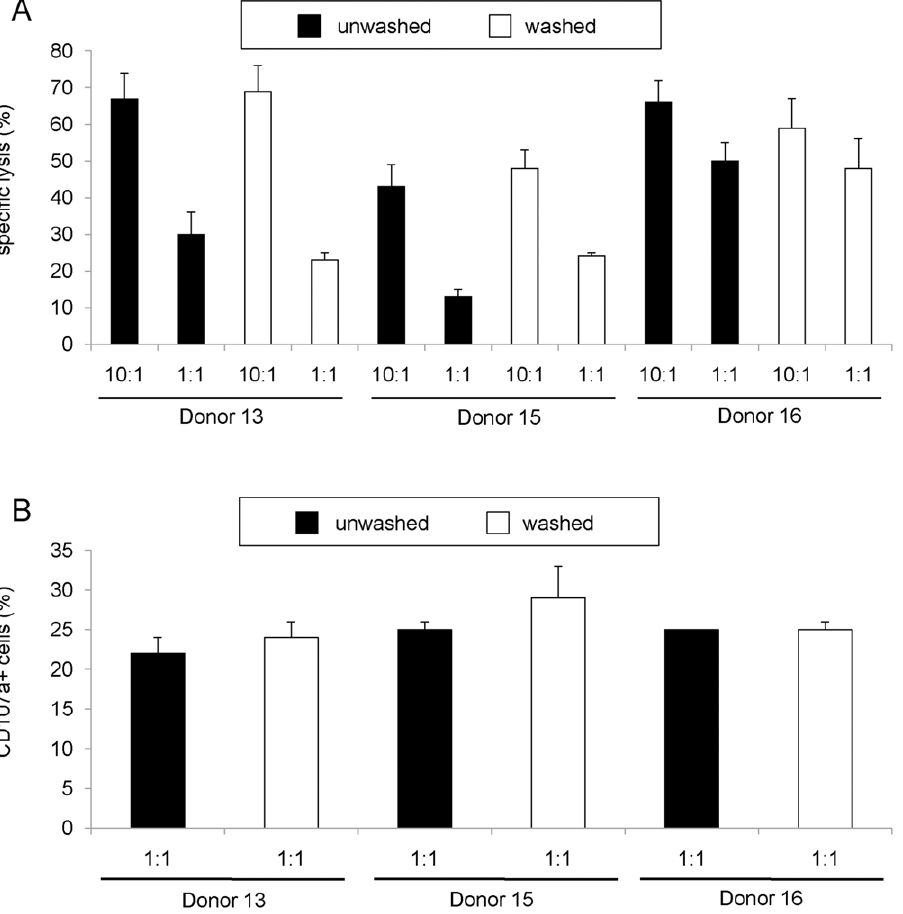
Figure 2. Functional activity of e xvivo bioreactor-expanded NK cells before and after the washing process. ( A ) Cytotoxicity of ex vivo - generated NK cells against K562 cells was analyzed after 18 hours of co-culture with unwashed (black bars) and washed (white bars) NK cells from three different donors at an E:T ratio of 1:1 or 10:1. ( B ) Degranulation of ex vivo -generated NK cells against K562 was analyzed by CD107a expression after 18 hours of co-culture after of unwashed (black bars) and washed (white bars) NK cells from three different donors at an E:T ratio of 1:1.